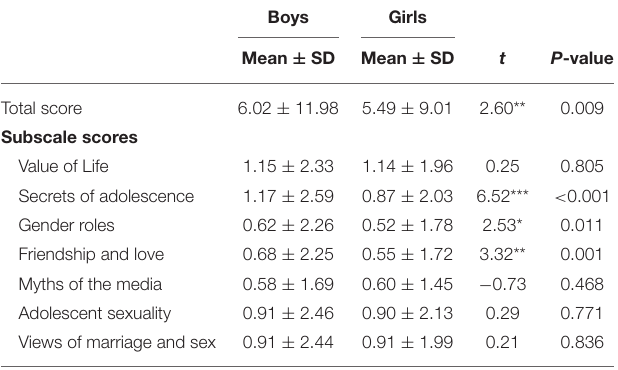
TABLE 3 | Difference in pretest and posttest scores on the PILSEE between elementary school students ( n = 10,200) and junior high school students ( n =